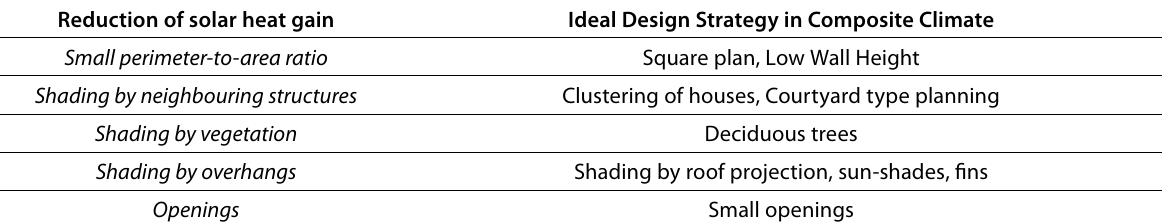
Table 1. Study on traditional rural dwelling units in the composite climatic region